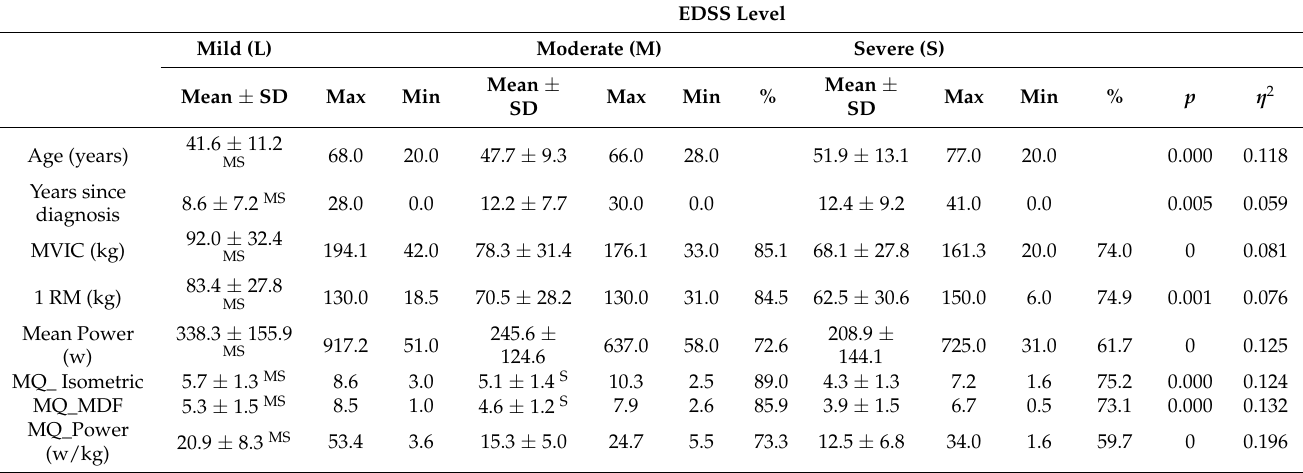
Table 6. Muscle strength and quality values according to the neurological disability